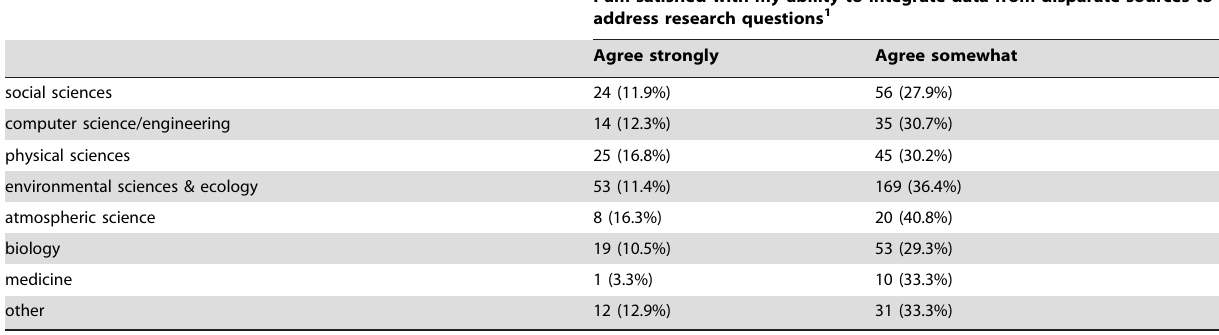
Table 15. Conditions for data sharing by subject discipline.